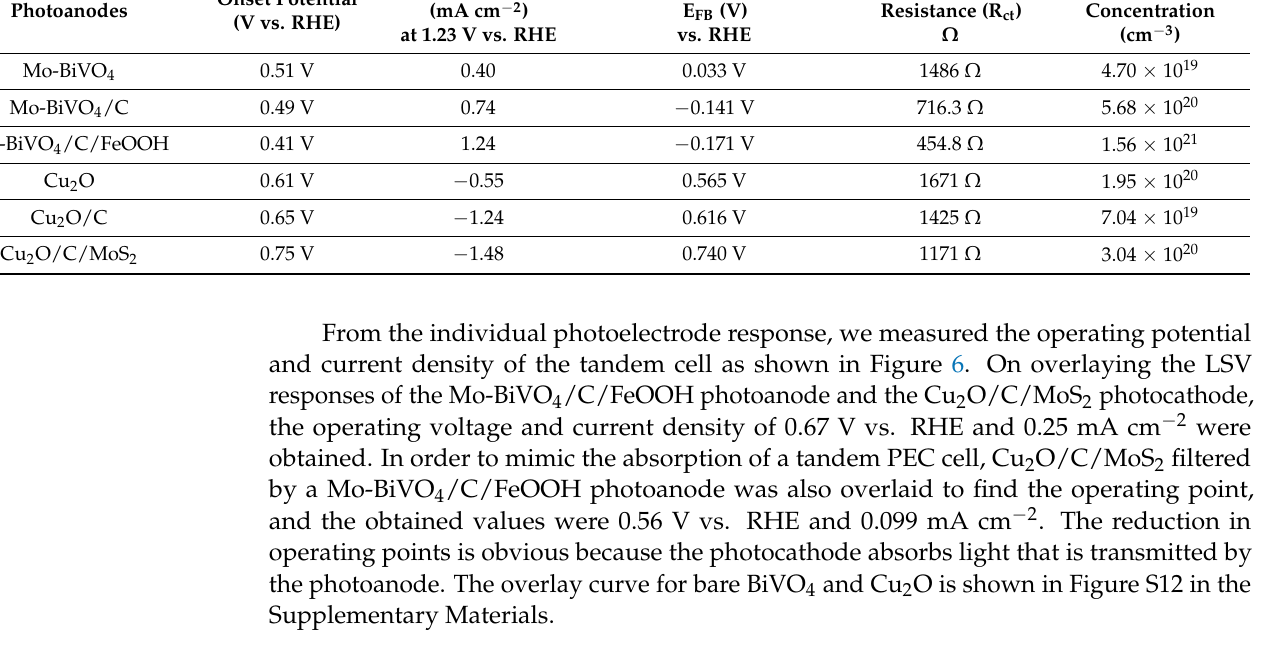
Table 1. Tabulation of PEC performance parameters for BiVO 4 photoanodes and Cu 2 O photocathodes.